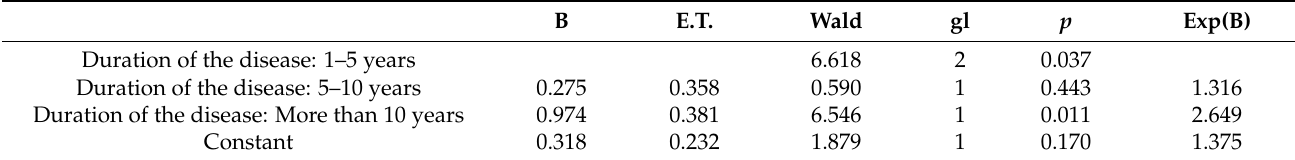
Table 7. Variables included in the proposed model. Diabetes Mellitus sujets.